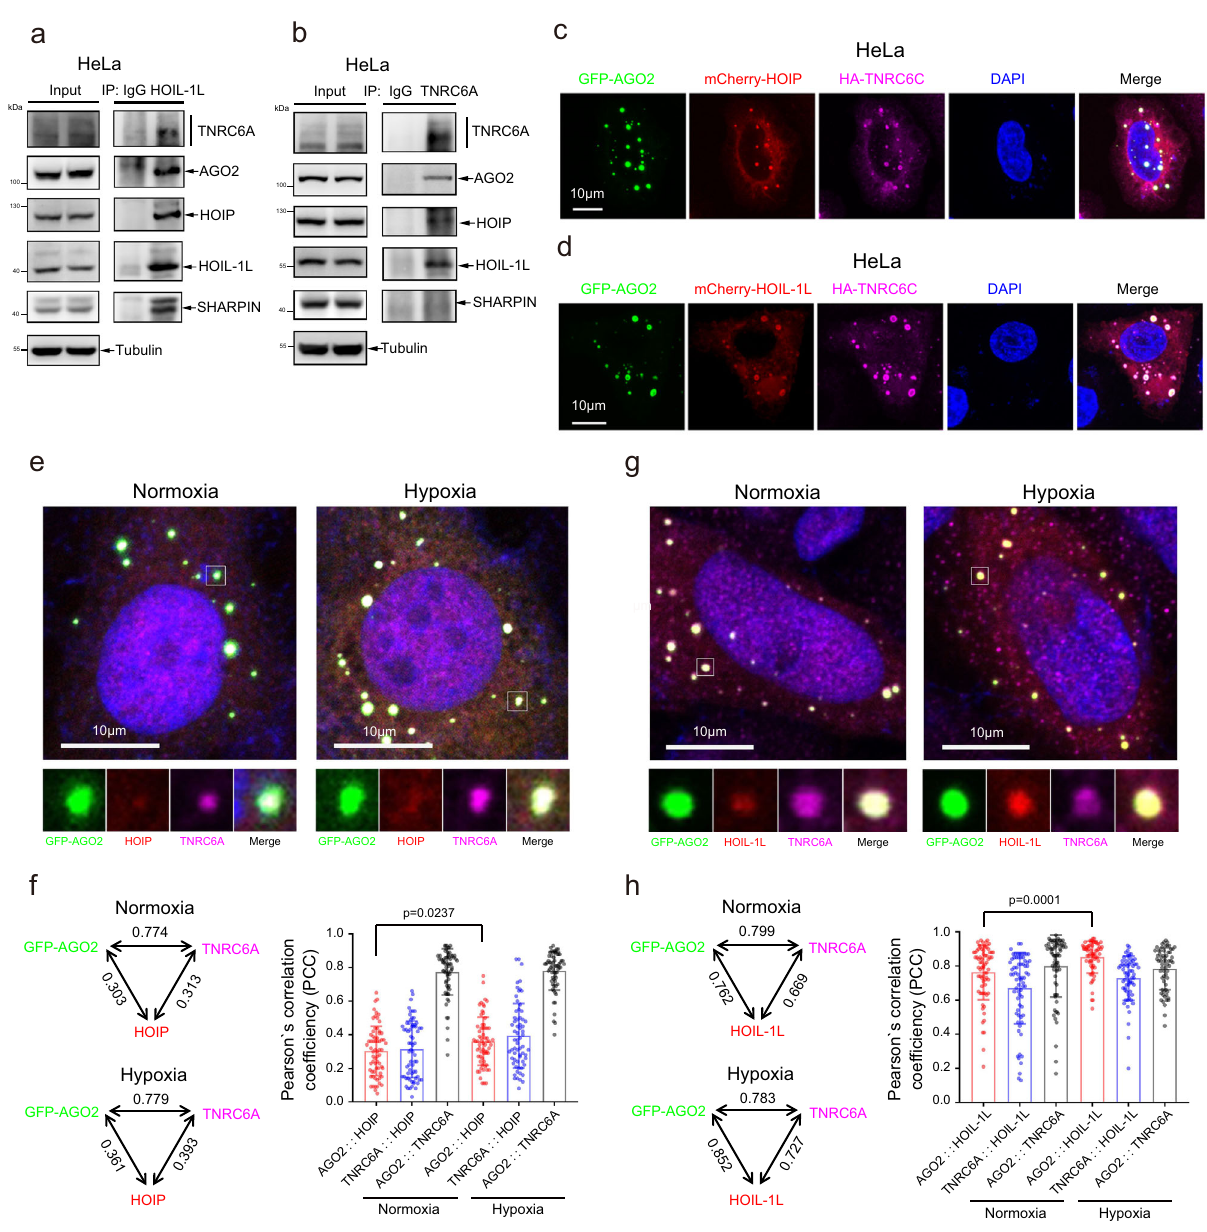
Fig. 4 HOIP and HOIL-1L co-localize with miRISC. a , b AGO2/TNRC6A interacted with LUBAC. HeLa cells were lysed for co-IP with anti-HOIL-1L ( a ) or anti-TNRC6A ( b ) antibody, and then the interactions between AGO2/TNRC6A with HOIP and HOIL-1L were detected by WB with indicated antibodies. c , d LUBAC was co-localized with AGO2/TNRC6C of miRISC. GFP-AGO2 and HA-TNRC6C were co-transfected with mCherry-HOIP ( c ) or mCherry-HOIL-1L ( d ) into HeLa cells, the co-localization of GFP-AGO2 (green), TNRC6C (purple) with mCherry-HOIP (red) or mCherry-HOIL-1L (red) were observed by immuno fl uorescence staining. e – h Hypoxia increased the co-localization of HOIP and HOIL-1L to AGO2/TNRC6A miRISC. GFP-AGO2 was transfected into HeLa cells, the co-localization of GFP-AGO2 (green), TNRC6A (purple) with HOIP (red) or HOIL-1L (red) were observed by immuno fl uorescence staining. The scale of the magni fi ed region (white frame) is 2 μ m x 2 μ m ( e , g ). Co-localization between GFP-AGO2/TNRC6A with HOIP or HOIL-1L were analyzed by Pearson ’ s correlation coef fi cient. Data were mean ± s.d., and P -values were determined by unpaired two-sided t-test ( f , h interaction of AGO2 with TNRC6A (Supplementary Fig. 6e, f). Consistently, the number of GFP-AGO2/TNRC6A co- localization foci per cell was not in fl uenced when HOIP and HOIL-1L were stably overexpressed or OTULIN was knocked down by shRNA in HeLa cells (Supplementary Fig. 6g, h).